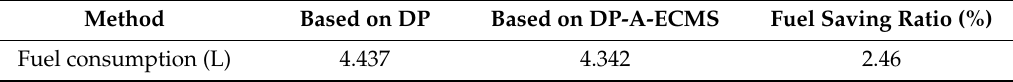
Figure 12. Battery SOC change curve of the neural network strategy. Table 3. Comparison of control strategies based on the neural